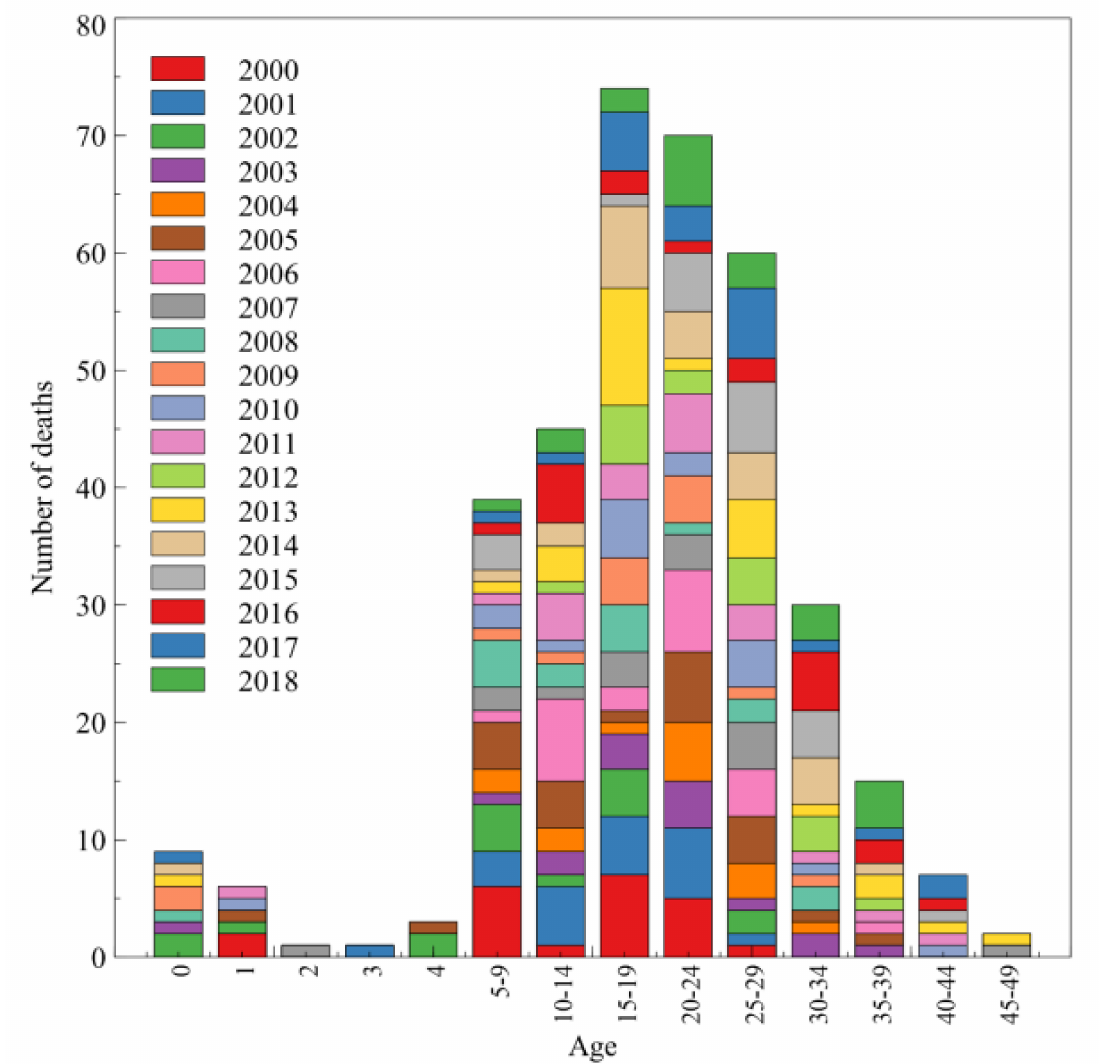
Figure 4. Number of deaths depending on the patient’s